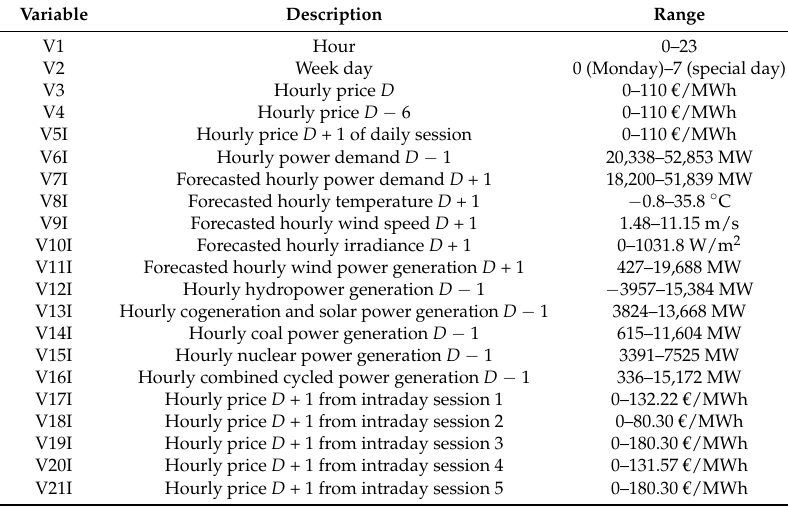
Table 7. Variables of ISMPF